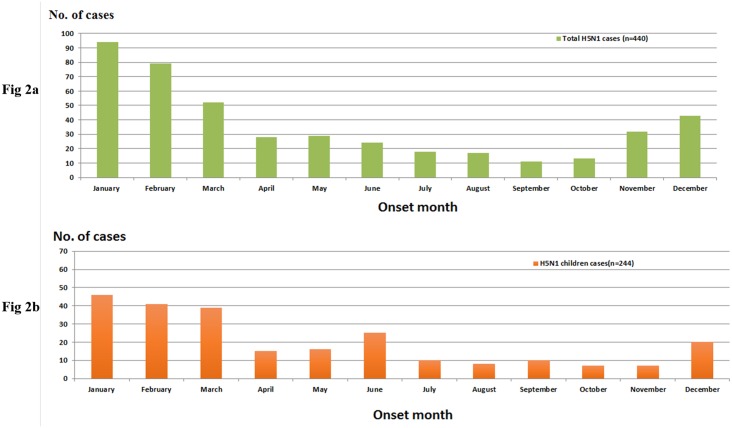
Monthly distribution curve of confirmed avian influenza A(H5N1) cases in the overall global population and in children between 2006 and June 13, 2016.Notes: Fig 2a: Total cases (N = 440); Fig 2b: Childhood cases (N = 244).